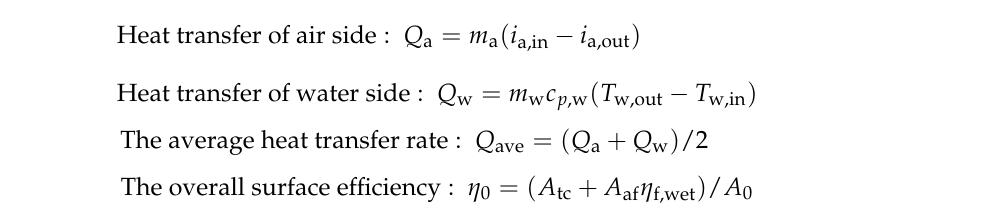
Figure 3. Schematic diagram of CCD cameras arrangement.